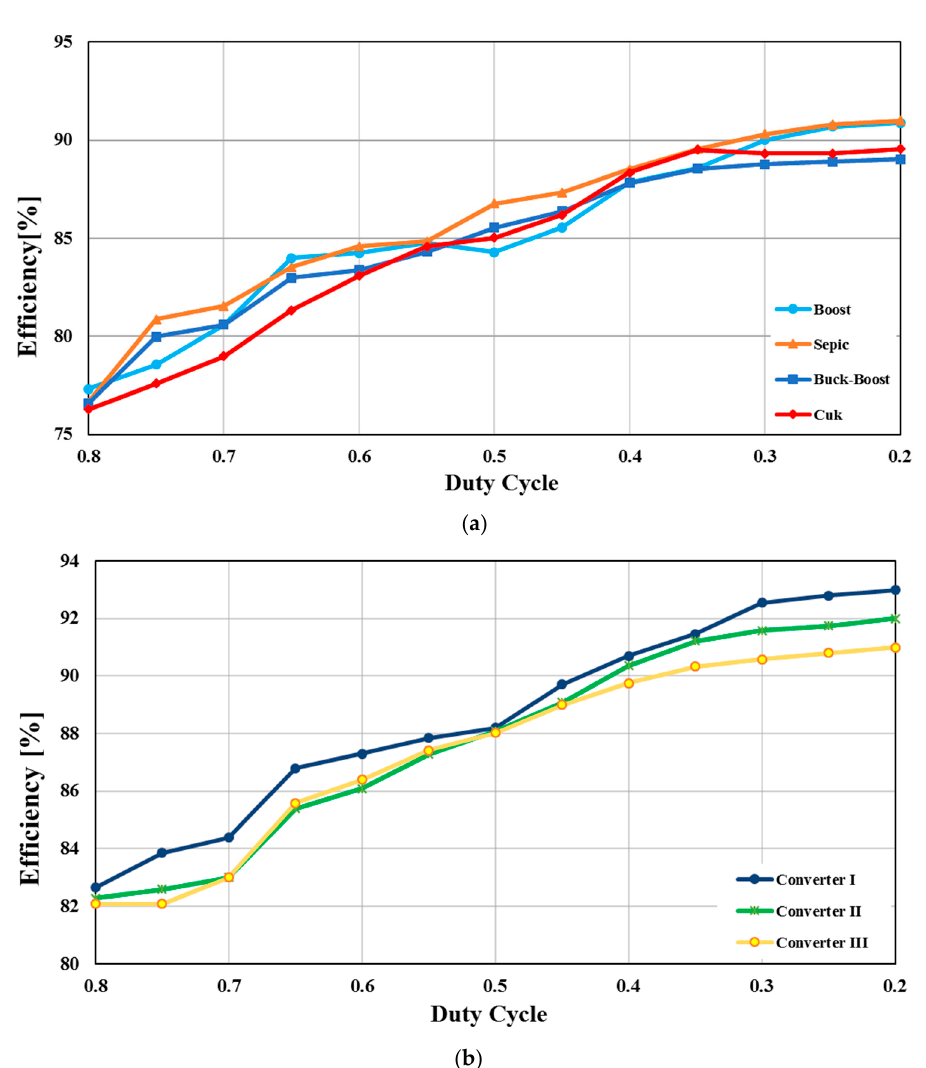
Figure 13. Efficiency comparison of the proposed converters and traditional converters. ( a ) traditional converters; ( b ) proposed converters.